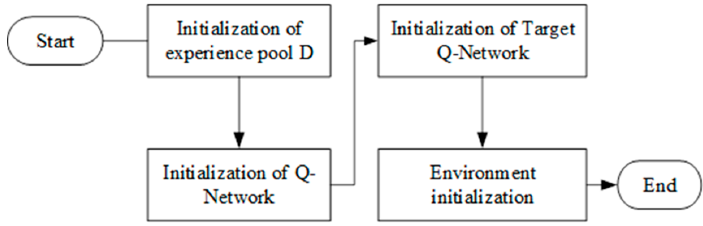
Figure 10. Flowchart of initialization.